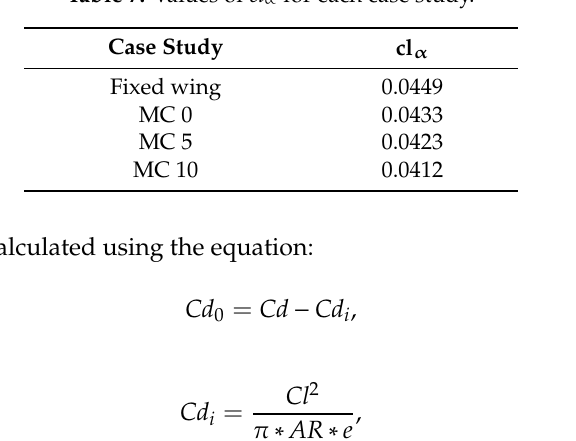
Table 7. Values of cl ∝ for each case study.